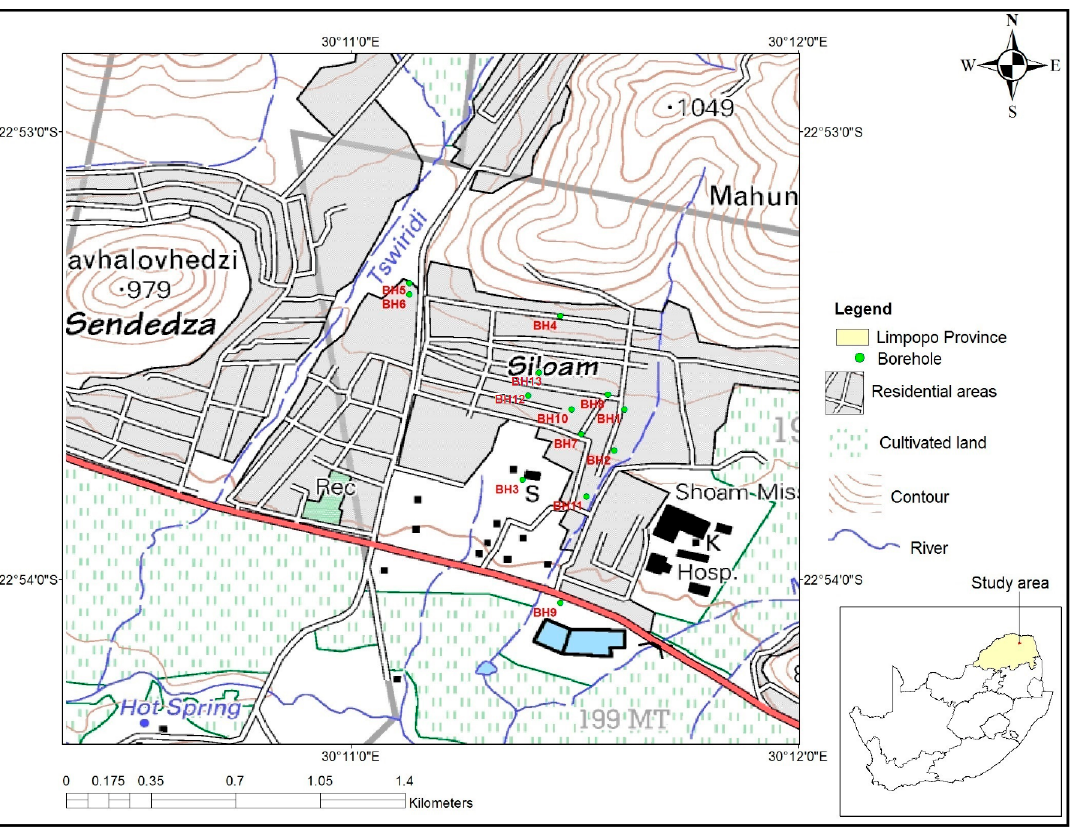
Figure 1. Location of the study area.